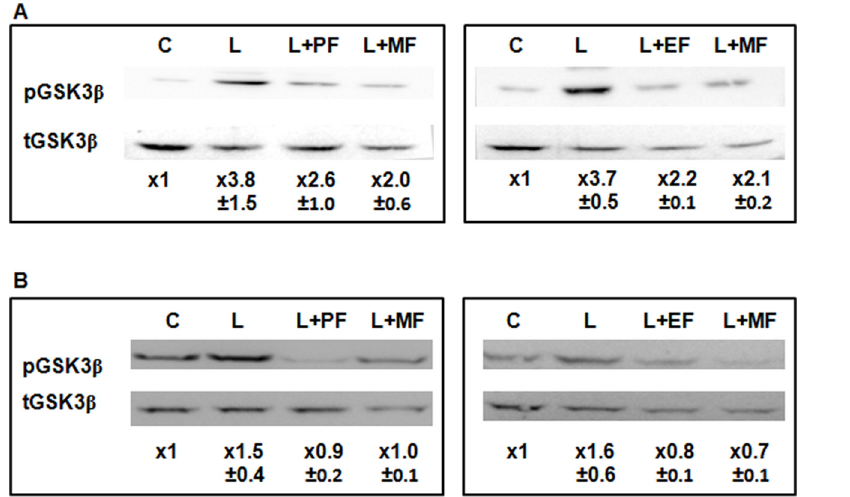
Figure 3. Inhibition of Akt kinase activity by ALP compounds in HIV-1 vector transduced or Tat expressing CHME5 cells. ( A ) CHME5 cells transduced with DHIV-GFP giving , 90% transduction and ( B ) Tat expressing CHME5 subline cells were exposed to LPS (50 m g/ml)/CHX (10 m g/ ml) in the presence or absence of the ALP compounds for 24 hours. Ratios between the levels of phospho-specific and total GSK3 b proteins were determined and normalized as described in Figure 2. C: control cells not treated with stress, L: LPS and CHX stress treatment, PF: perifosine, EF: edelfosine, MF: miltefosine.